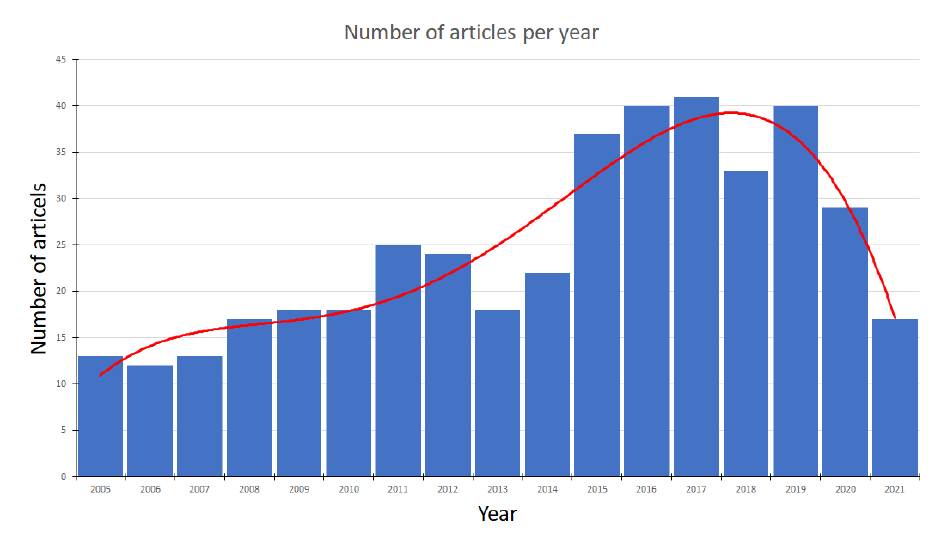
Figure 14. Histogram of articles about